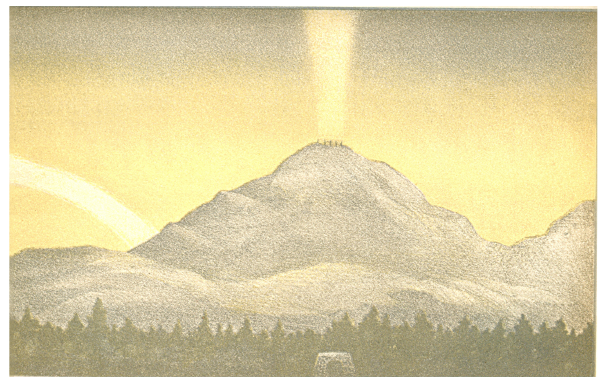
Figure 7. Image of the reported operation of Lemstr¨om’s “aurora discharge generator” (from Lemstr¨om,